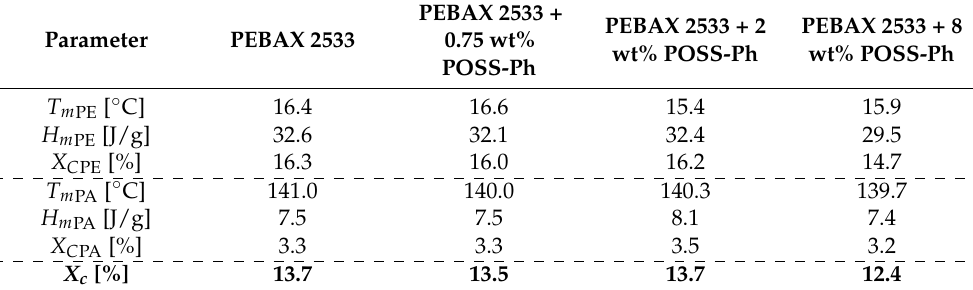
Table 3. DSC analysis results for membranes containing